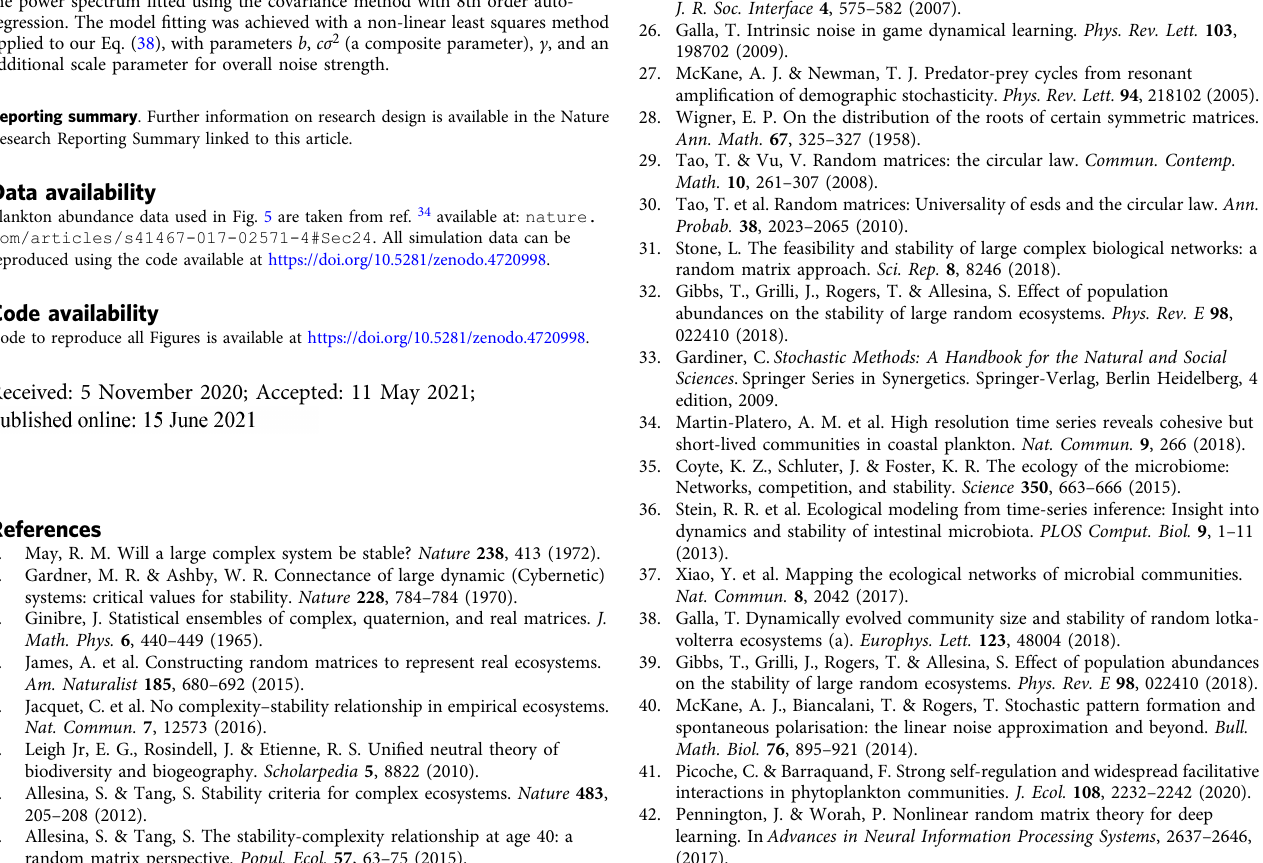
generated for the fi rst species. Figure 1, right panel . A two-trophic level model ecosystem was generated as described above. Parameters in this case were: Nx = 200, N y = 800, c x = 20, c y = 5, α = 10, b = 1, d = 1. Time series and power spectra were computed similarly to the left panels. Figure 2 . For the left panel, we generated Lotka-Volterra ecosystems with para- ffiffi p ð meters N = 1000, c = 50, σ 2 = 0.5, using b ¼ 2 þ ð 1 þ γ Þ c (cid:4) σ 2 Þ for the simula- tions with γ = 0 and γ = 1. Time series and spectra were computed similarly to Fig. 1. For the right panels more care is needed. Finite random matrices typically ffiffiffiffi p have a small number of eigenvalues that are order 1 = N larger than predicted by the stability boundary in the limit N → ∞ . To achieve the near-instability results in this fi gure, we fi rst generated the off-diagonal entries of the community matrices, then chose the birth rate b to put the rightmost eigenvalue of A exactly at zero. Figure 3 . Parameters here are: N = 500, c = 20, γ = − 1, σ 2 = 1/4/ c , b = 0.2. For the ‘ direct ’ results we numerically computed the power spectral density according to the matrix formula in Eq. (17). This was preferable to simulations of the time series, as a long time horizon is required to achieve good resolution of the indi- vidual contributions to the power spectral density. Figure 4 . Parameters here are: N x = 100, N y = 200, c x = 20, c y = 10, α = 5, b = 1, d = 1. Figure 5 . The dataset 41467_2017_2571_MOESM6_ESM.xlsx was imported into Matlab and processed as follows: We took the average of the three reported daily measurements to construct an 88-day time series for each species. To limit boundary effects we discarded all species with at least one with zero measured abundance, in doing so retaining 100 species. The mean was subtracted and then the power spectrum fi tted using the covariance method with 8th order auto- regression. The model fi tting was achieved with a non-linear least squares method applied to our Eq. (38), with parameters b , c σ 2 (a composite parameter), γ , and an additional scale parameter for overall noise